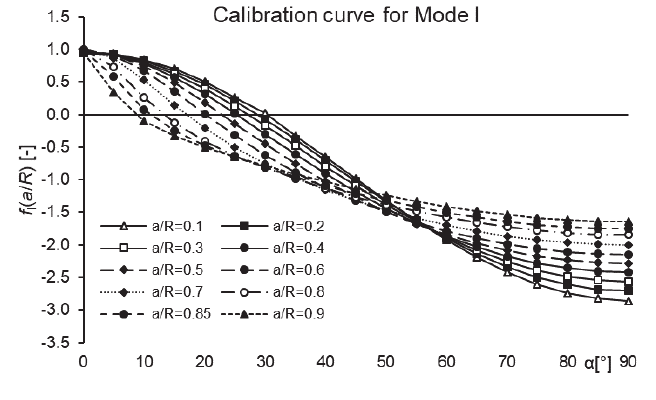
Figure 2: Calibration curve f I ( a / R,  ) for mode I.